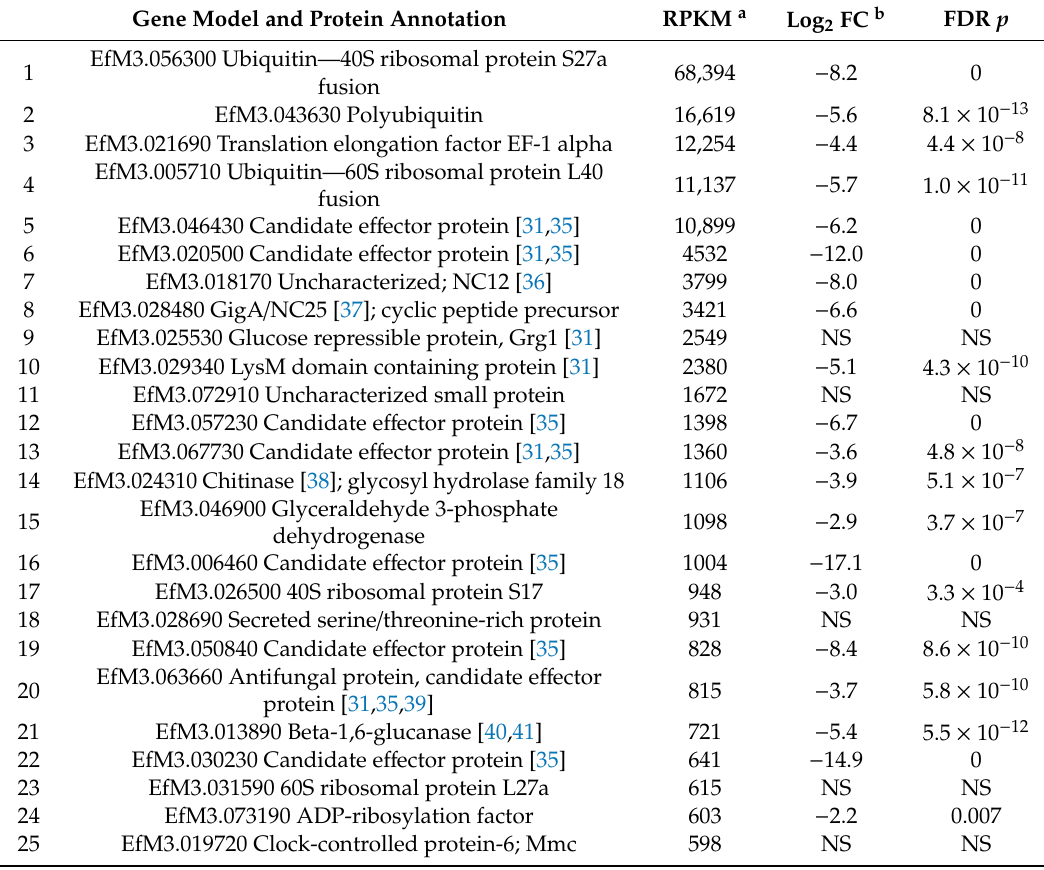
Table 3. The 25 most abundant Epichloë festucae transcripts in asymptomatic strong creeping red fescue inflorescence